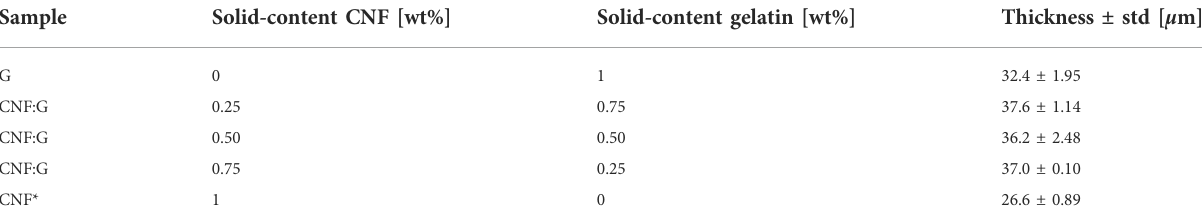
TABLE1Overviewofthevariouscompositionsoftheactuator fi lmsmanufactured.Ofeachcomposition fi vesamplesweretested.Notethatthe fi lms marked with an asterisk were manufactured through vacuum fi ltration. Sample